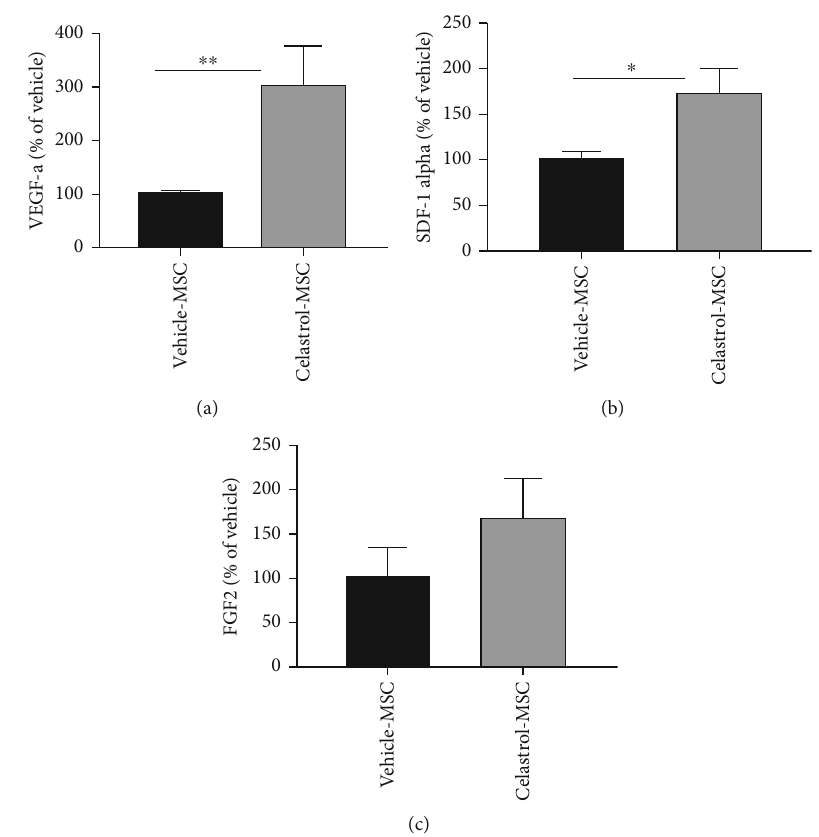
Figure 4: Celastrol preconditioning increases the amount of angiogenic factors released by encapsulated hMSC: (a) VEGF-a ( mean ± SEM , n ≥ 6 , N = 4 ); (b) SDF-1 α ( mean ± SEM , n ≥ 12 , N = 4 ); and (c) FGF-2 ( mean ± SEM , n = 6 , N = 3 ) concentrations in conditioned media of hydrogel-encapsulated hMSC on day 4 ( ∗∗ p < 0 : 01 and ∗ p < 0 : 05 ; no signi fi cant di ff erence between groups with FGF-2 ( mean ± SEM , n = 6 , N = 3